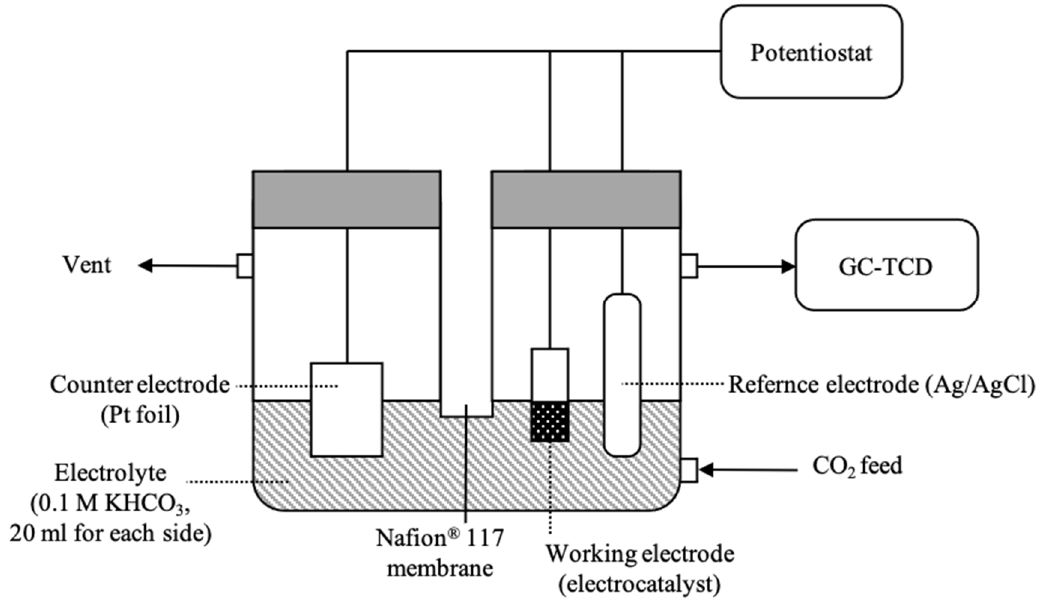
Figure 1. Schematic electrochemical CO 2 reduction